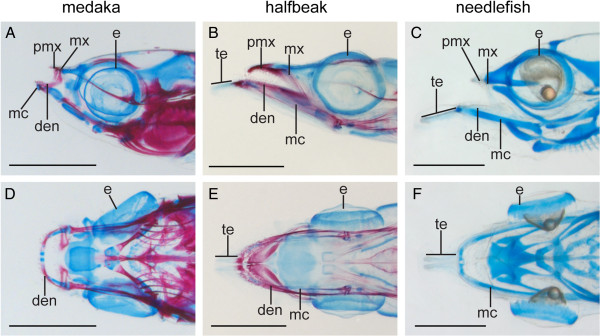
Contribution of the toothless extensions to heterochronic jaw growth in representatives of the Belonoidei. Alcian blue/alizarin red staining indicates that needlefish (B. belone) and halfbeak (D. pusilla) have toothless extensions of the lower jaw that are not present in medaka (O. latipes). (A, C, E), lateral orientation, (B, D, F) ventral orientation; age matched representatives, including (A, B) 28 dph medaka, O. latipes, (C, D) 7 dpb halfbeak, D. pusilla, (E, F) 6 dph needlefish, B. belone. Abbreviations: bl = body length, e = eye, lj = lower jaw, ljb = lower jaw basis, te = toothless extensions, uj = upper jaw.